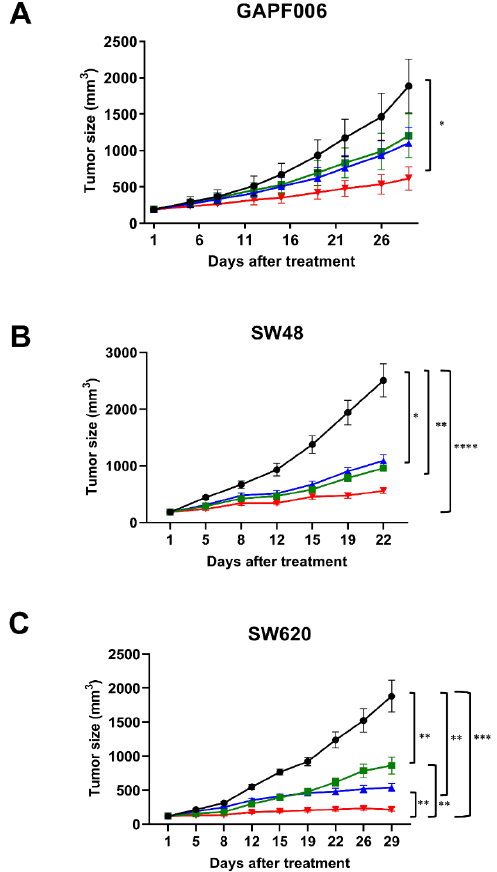
Figure 2. ABL001 in combination with chemotherapy with paclitaxel or irinotecan synergistically inhibited tumor progression in human gastric PDX and colon cancer xenograft models. In GAPF006 human gastric PDX model ( A ), mice were treated with vehicle (closed circle, black), paclitaxel alone (closed rectangle, green), ABL001 (closed triangle, blue), or a combination of ABL001 and paclitaxel (closed reverse triangle, red). Compared to vehicle, each treatment group inhibited tumor progression (40.33% TGI in paclitaxel, 46.20% TGI in ABL001, and 74.75% TGI in the combination treatment). In the studies using SW48 ( B ) and SW620 ( C ) colon cancer xenograft models, mice were treated with vehicle (closed circle, black), irinotecan alone (closed rectangle, green), mABL001 (closed triangle, blue), or a combination of mABL001 and irinotecan (closed reverse triangle, red). In the case of both colon cancer xenograft models, the combination treatment of mABL001 and irinotecan showed the most potent effects on tumor progression (77.7% TGI in SW48 and 94.47% TGI in SW620 xenograft models). Each line represents the average tumor size (mm 3 ) of each treatment group ± SEM. * p < 0.05, ** p < 0.01, *** p < 0.001, **** p < 0.0001 by Tukey’s test.